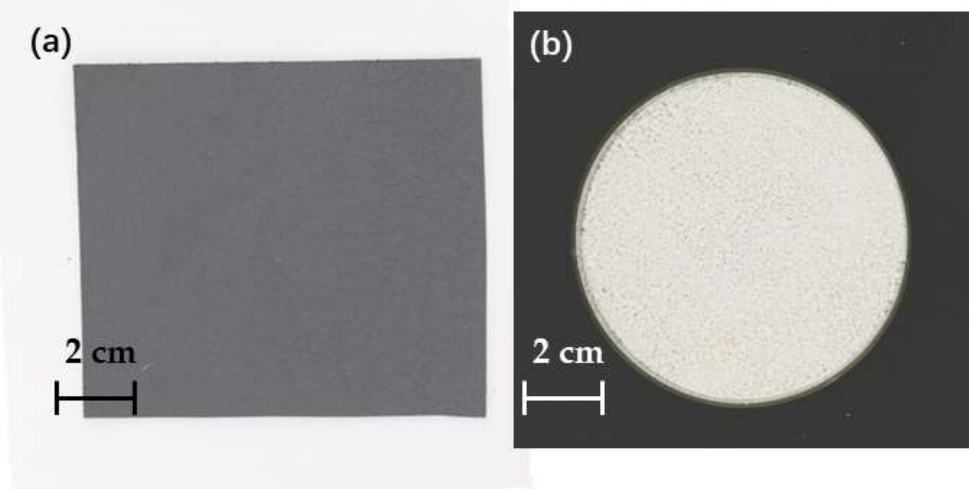
Figure 2. ( a ) Digieye top view shot of PPS film; ( b ) Digieye top view shot of PPS particles.